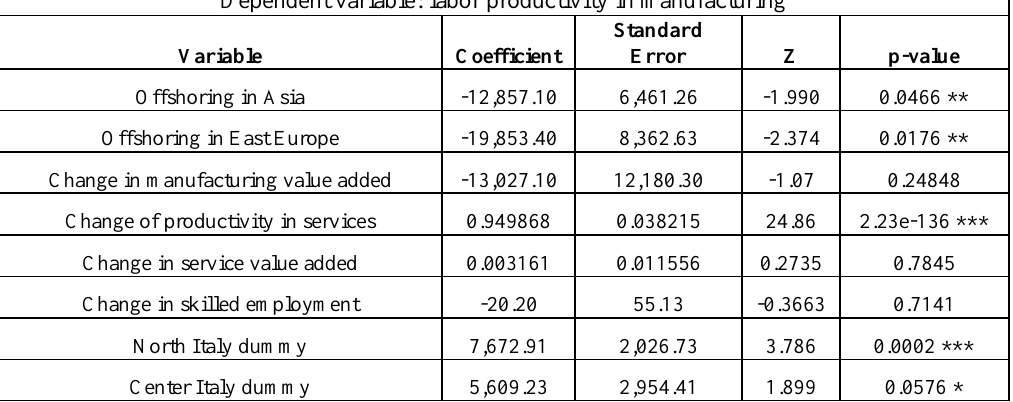
Table 7: Explaining Manufacturing Labor Productivity in Italian Provinces 1999- 2010 Dependent variable: labor productivity in